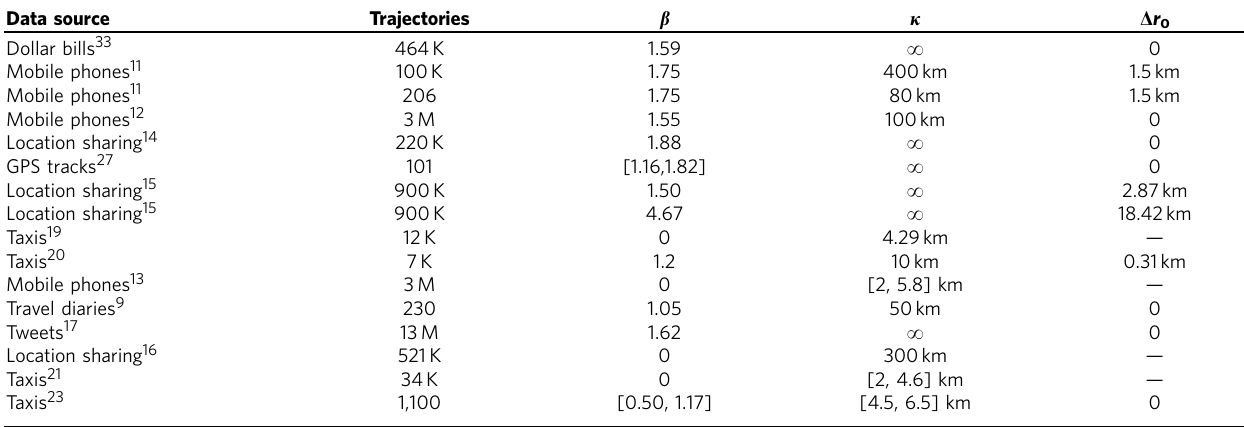
Table 1 | Parameter values for the fit of the displacement distribution with a truncated power law found in previous